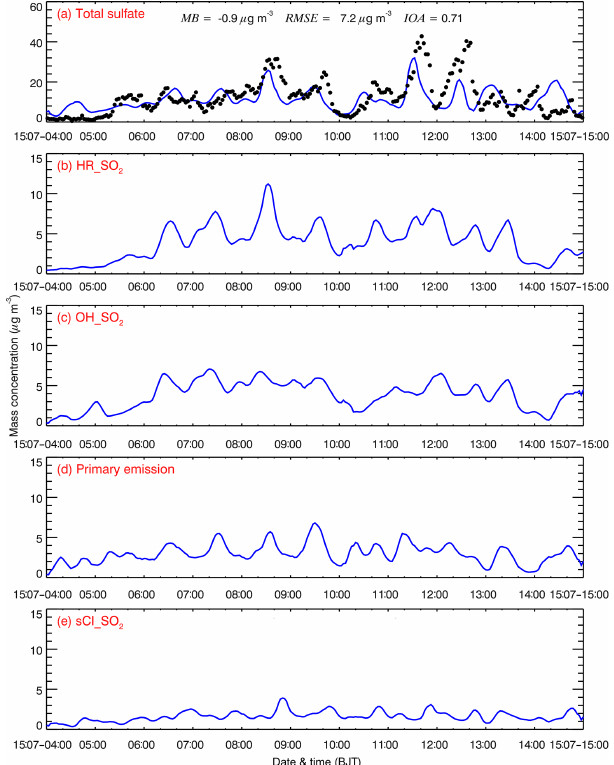
Figure 6. (a) Comparison of observed (black dots) and simulated (blue line) diurnal profiles of the hourly submicron sulfate mass concentration and the temporal variation of the simulated sulfate contribution of (b) HR_SO 2 , (c) OH_SO 2 , (d) primary emissions, and (e) sCI_SO 2 to the sulfate concentration at the NCNST site in Beijing from 4 to 15 July 2015.